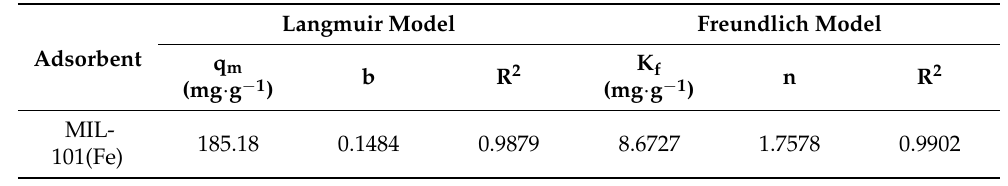
Figure 7. Chemical diagram involving the two-step mechanism. Table 2. Isotherm parameters of silicic acid adsorption process.